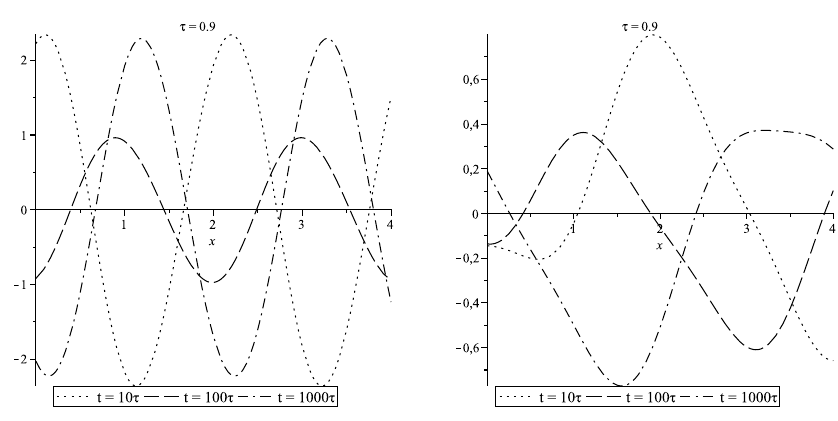
Figure 5. Profiles of waves u,v at time moment τ = 0 .